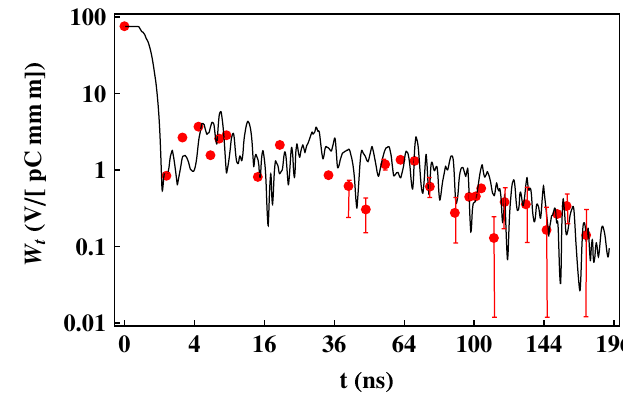
FIG. 10. (Color) Spectral simulation (solid line) and experimen- tal measurements (red dots) of the envelope of the wakefield for DDS3. Random errors in the cell frequencies are also included in the simulation with an rms value of 12